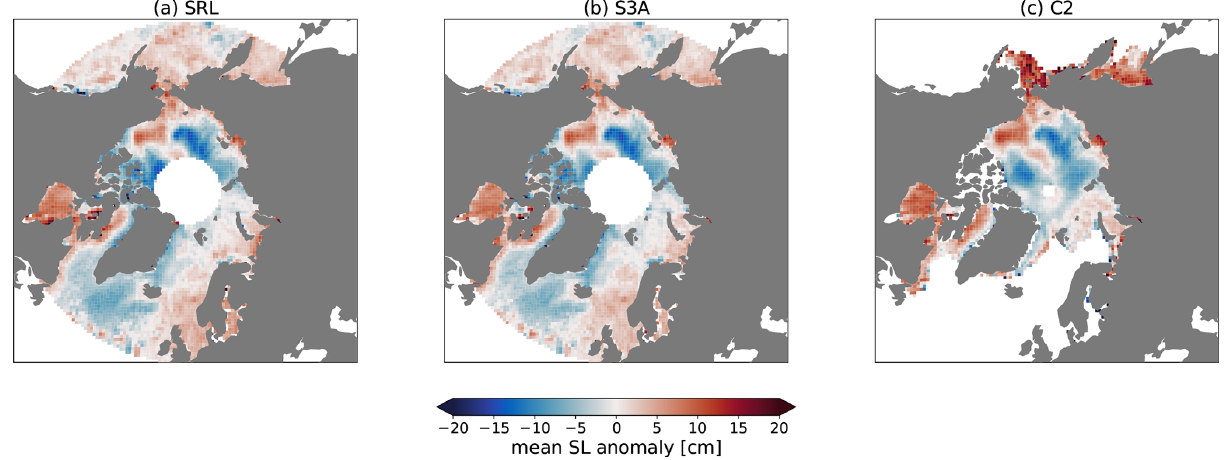
Figure 2. Mean Arctic SLA maps for SRL (a) , S3A (b) and C2 (c) . All maps are estimated over the time span common to all missions (July 2016–April 2019).